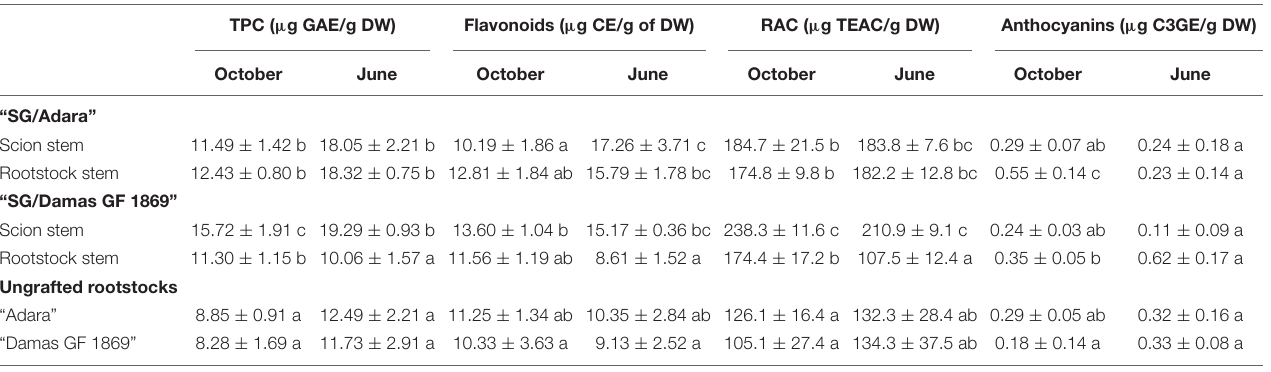
TABLE 3 | Total phenolic content (TPC), flavonoids, anthocyanins, and relative antioxidant capacity (RAC) in the bark from the scion and rootstock of the compatible (“SG/Adara”) and incompatible (“SG/Damas GF 1869”) graft-combinations, and ungrafted rootstocks at leaf fall (October) and vegetative (June) periods. TPC ( µ g GAE/g DW) Flavonoids ( µ g CE/g of DW) RAC ( µ g TEAC/g